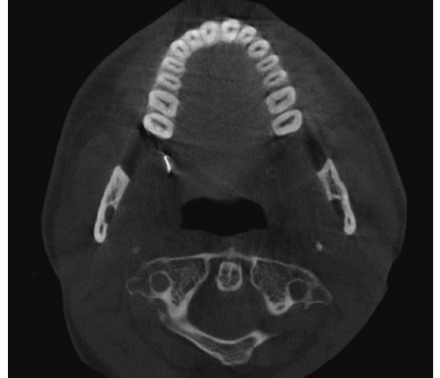
Figure 1: Coronal view.